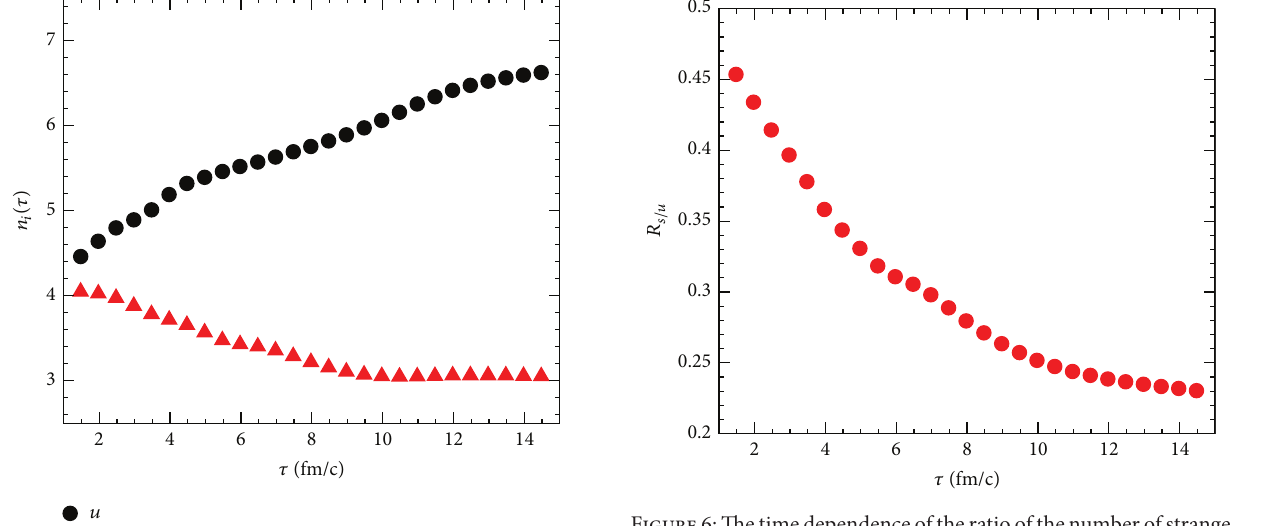
Figure 6: The time dependence of the ratio of the number of strange quarks to the number of light quarks (color